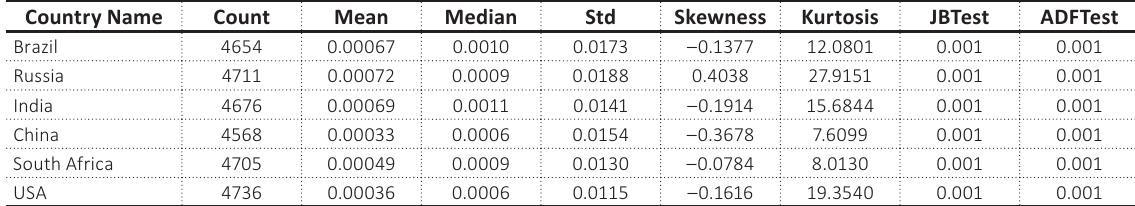
Table 1. Descriptive statistics of the return